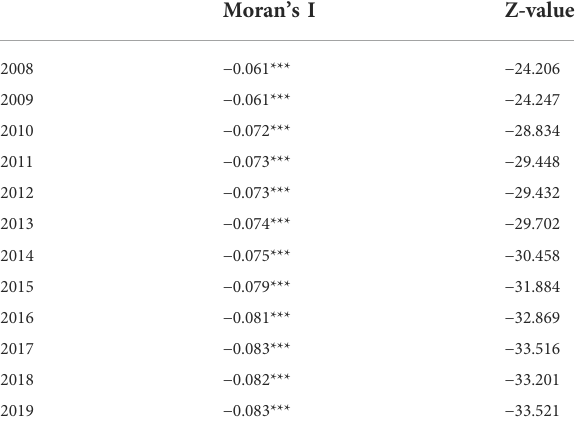
TABLE 3 Calculation of Moran ’ s I index of urban carbon emission